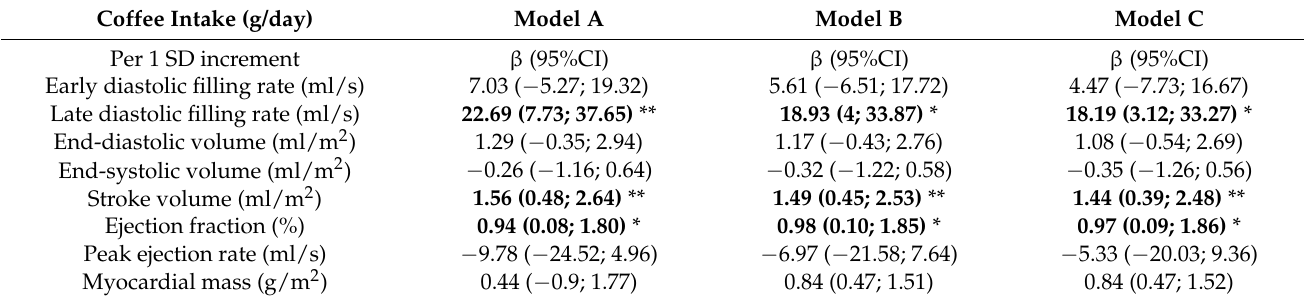
Table 4. Associations between coffee intake and cardiac MRI